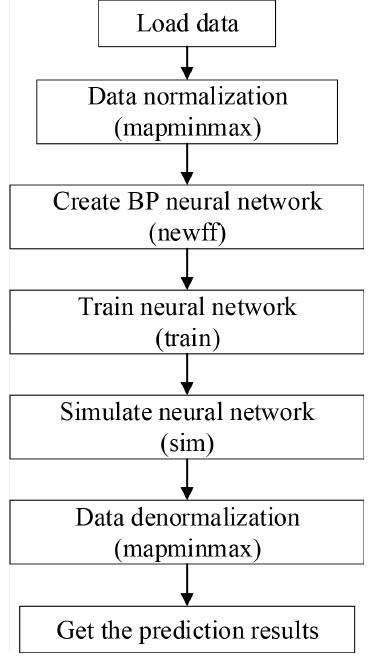
Figure 5. The flowchart of training BPNN.